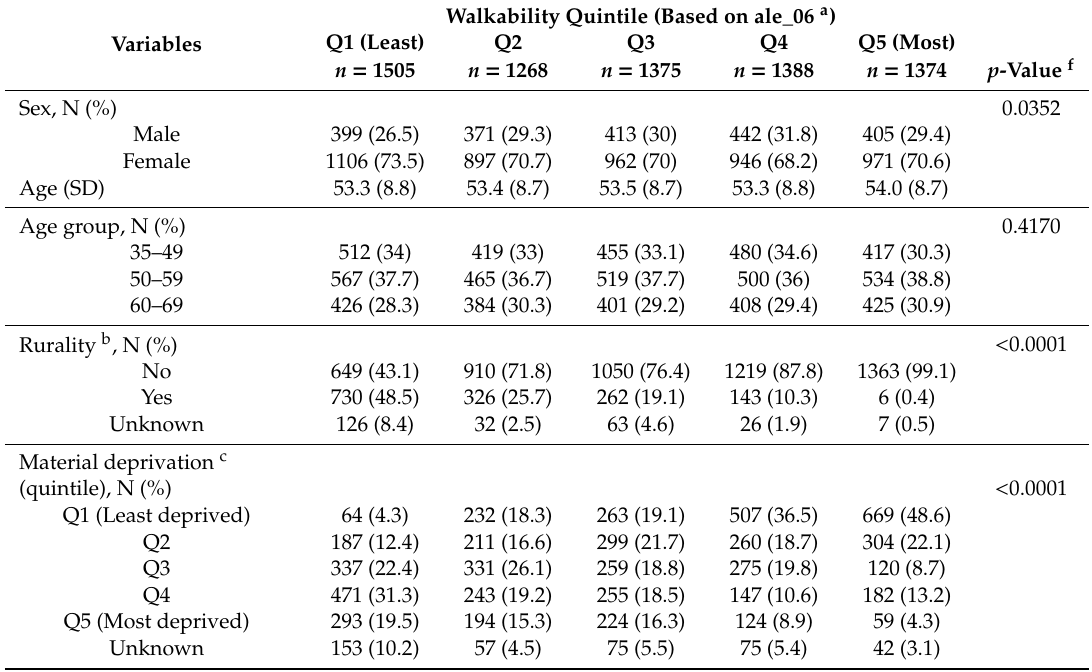
Table 3. Sociodemographic and health-related participant characteristics categorized by walking quintile at